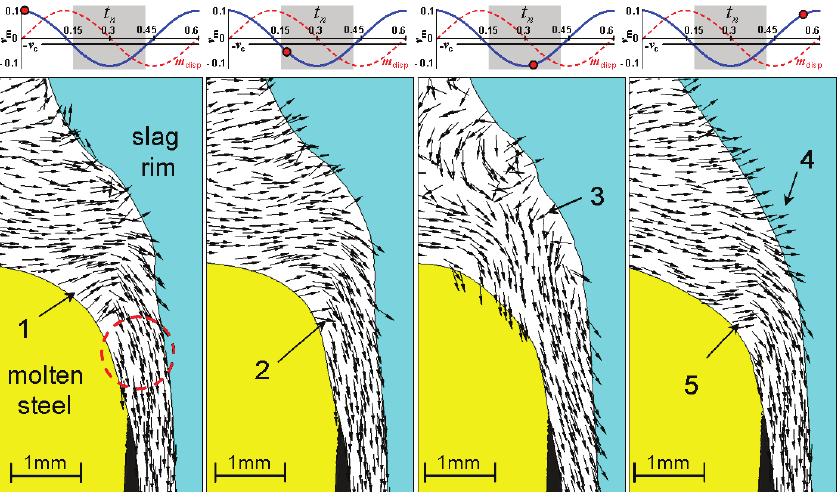
Figure 8. Predicted slag flow in the meniscus for V c D 0.6 m = min at four points (solid dot on mould velocity curve) during an oscillation cycle, a) at t mid half way through negative strip and (d) returning to t mid